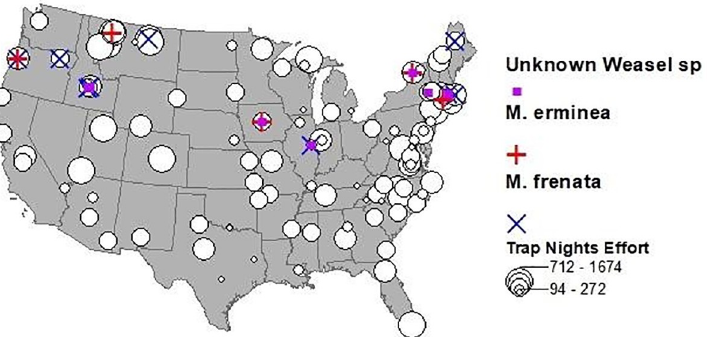
Fig 7. Results from the 2019 Snapshot USA mammal survey [21] which included 1509 trail cameras operated in 110 arrays in all 50 states (HI and AK not shown but did not detect weasels). Sample effort (trail camera nights) per array is shown by white dots while colored markers indicate which arrays detected at least one